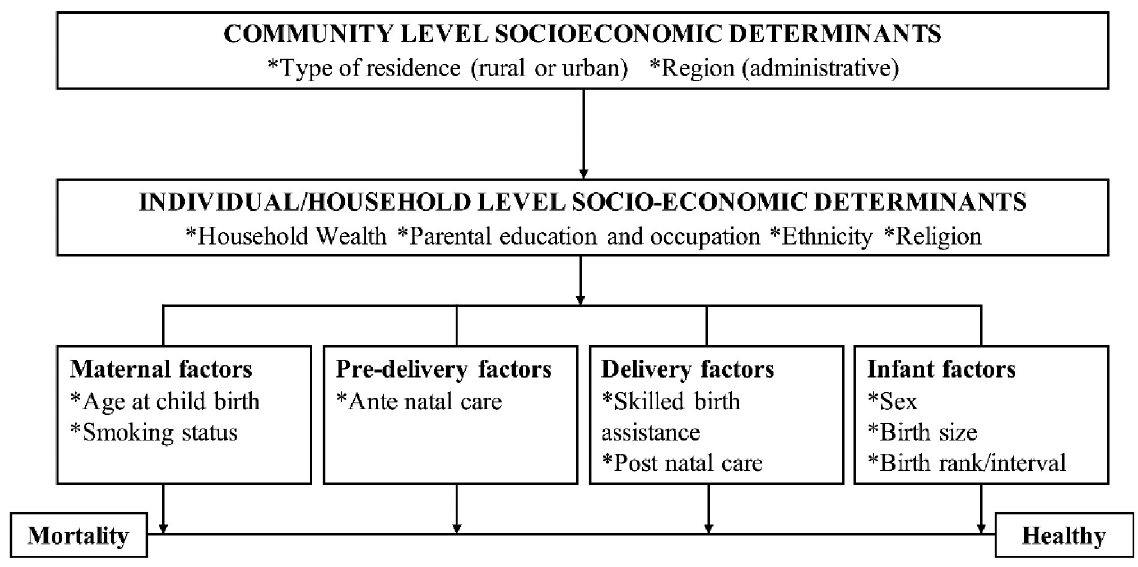
Fig 1. Conceptual framework of determinants influencing under-five mortality. Source: Mosley and Chen [16].